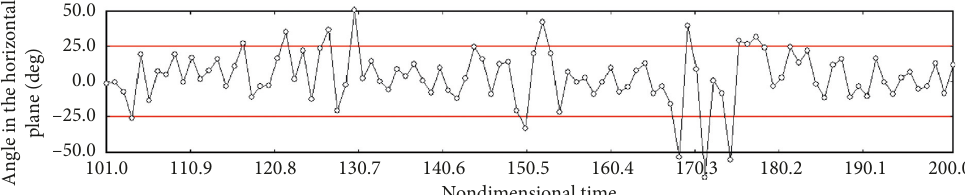
Figure 9: Time variation of wind direction (angle) within the horizontal cross section of the wind passing through the observation mast at 5m above ground.